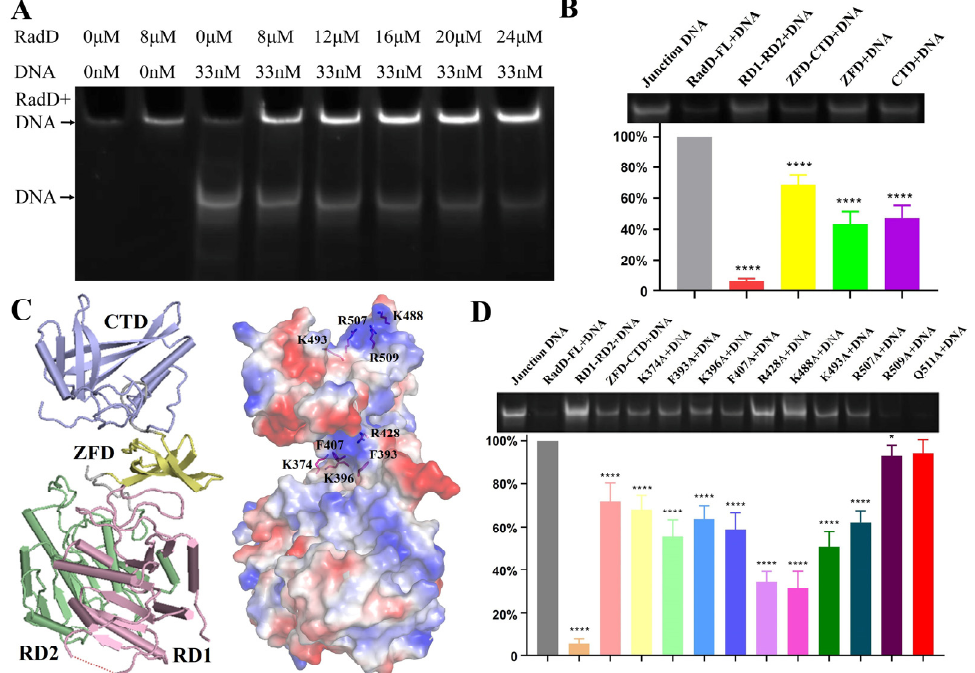
Figure 6. Specific interactions between RadD and branched DNA. ( A ) EMSA assays show that the branched DNA concentration decreases with the increase in RadD concentration. ( B ) EMSA assays and relative value statistics of RadD deletions combined with branched DNA. ( C ) The key amino acids binding to DNA are predicted in accordance with the surface potential diagram of the RadD/ATP structure. ( D ) Mutagenesis analysis of RadD and branched DNA interface residues, as shown by EMSA assays and relative value statistics. Error bars indicate the S.D. of at least three independent experiments, *means p − value < 0.1, **** means p − value < 0.0001.